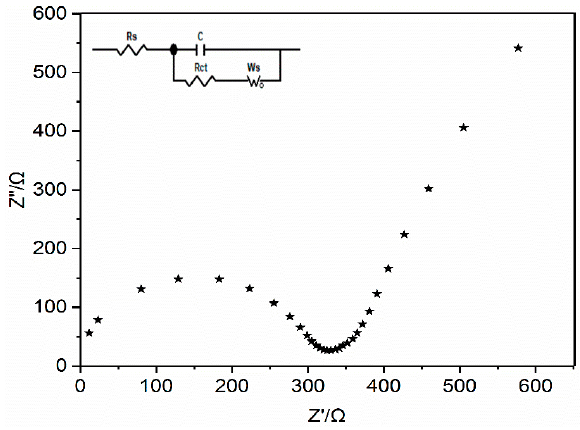
Figure 7. Nyquist plots of Br-doped PANI.